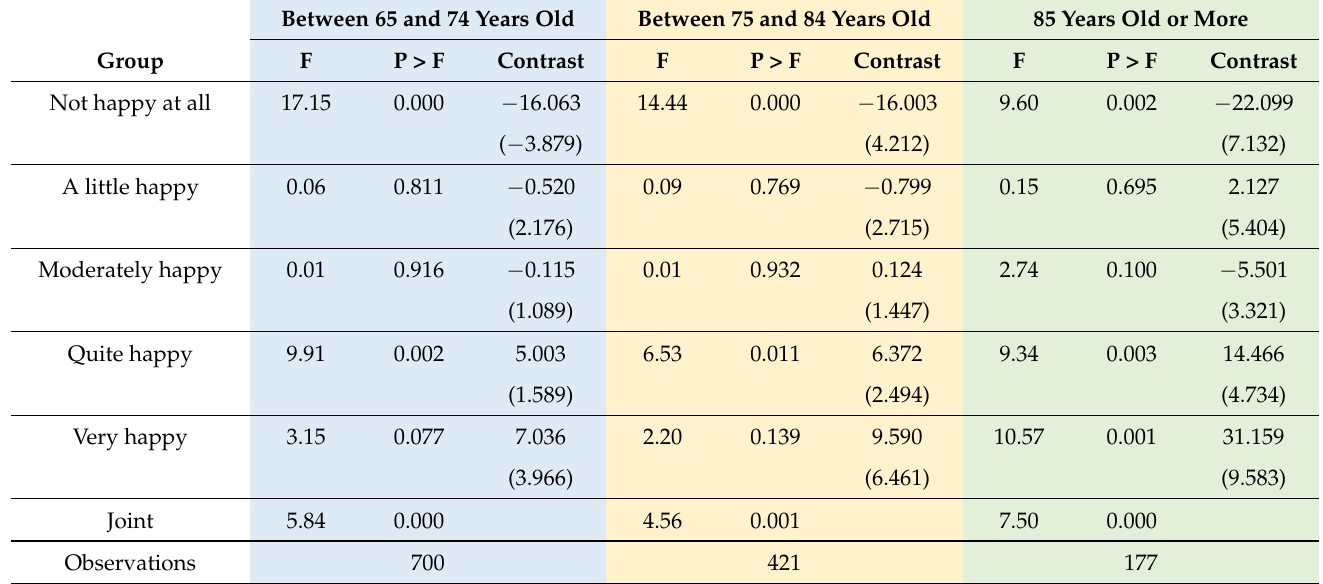
Table 2. Contrasts of marginal linear predictions of the equality of the means for each group with the observation-weighted grand